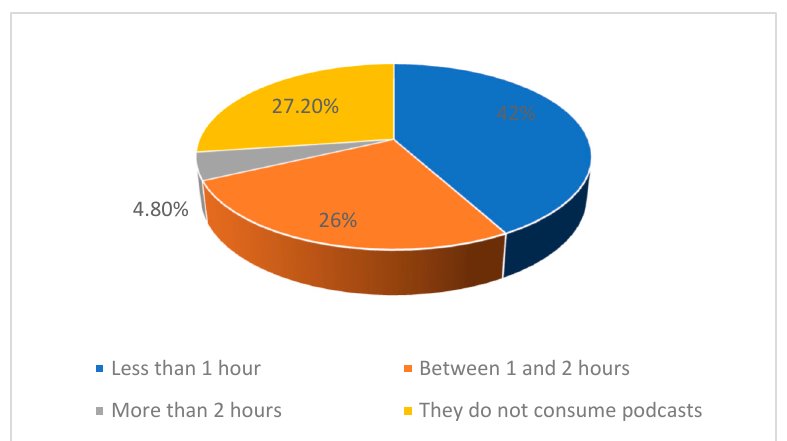
Figure 4. Graph of podcast consumption in university students (weekly hours). Source: Prepared by the author.